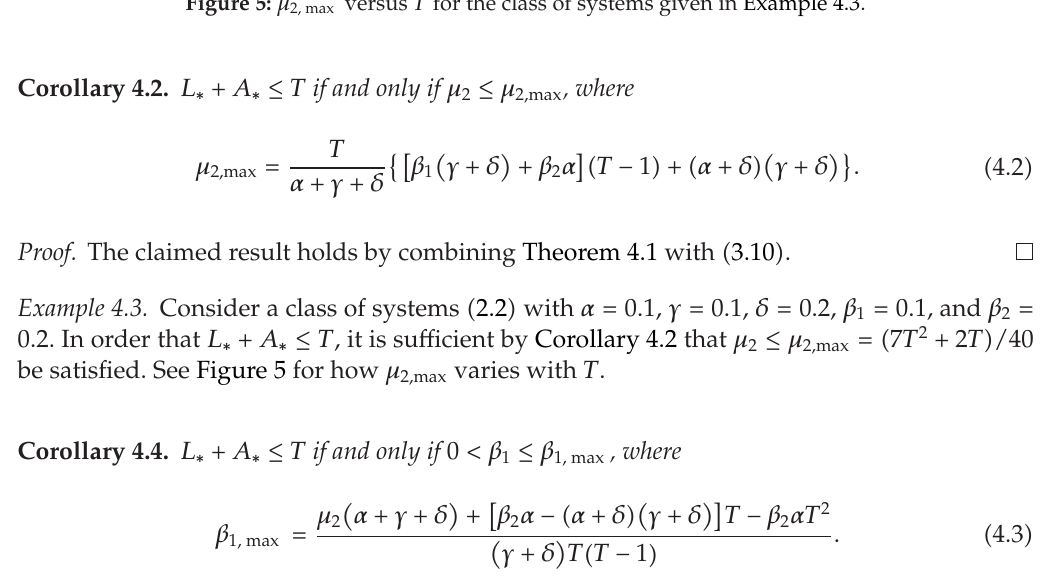
Figure 5: μ 2 , max versus T for the class of systems given in Example